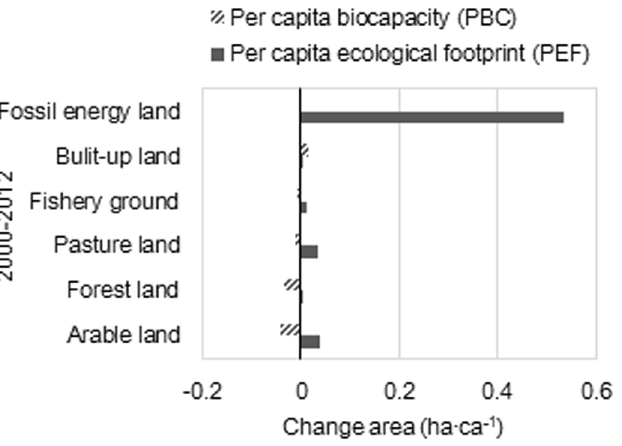
Fig 5. Change in area of six biologically productive land types between 2000 and 2012 in Xiamen City.